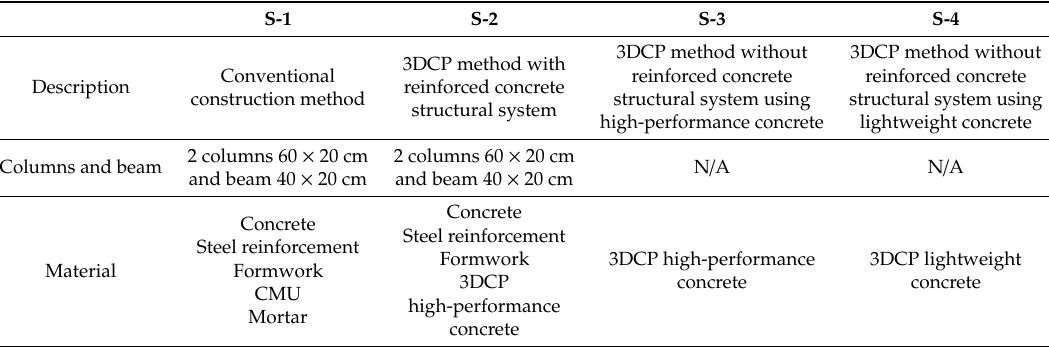
Table 1. Description of the four studied construction